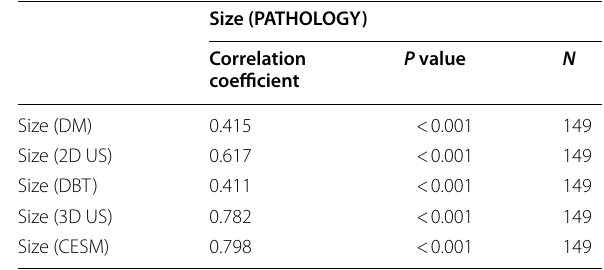
Table 1 The range, mean and SD of the size measured by each modality and the